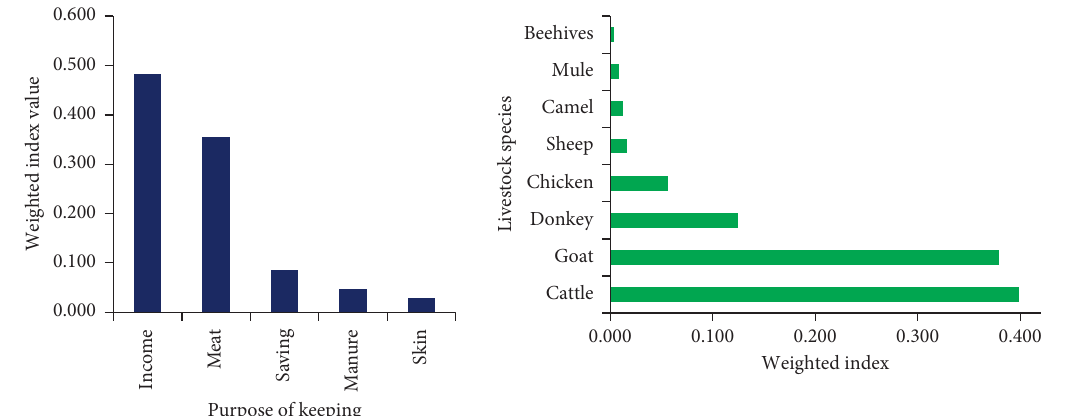
Figure 1: Purpose of goat keeping (left) and relative importance of livestock species